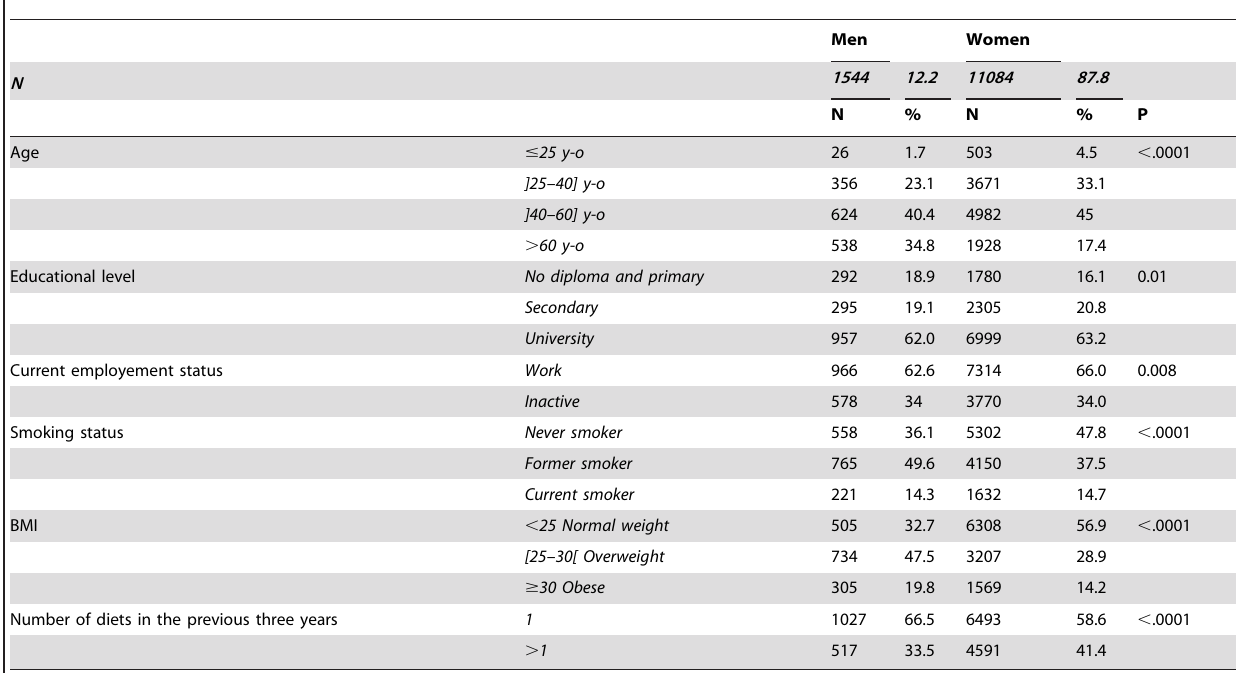
Table 1. Characteristics of dieters included in the